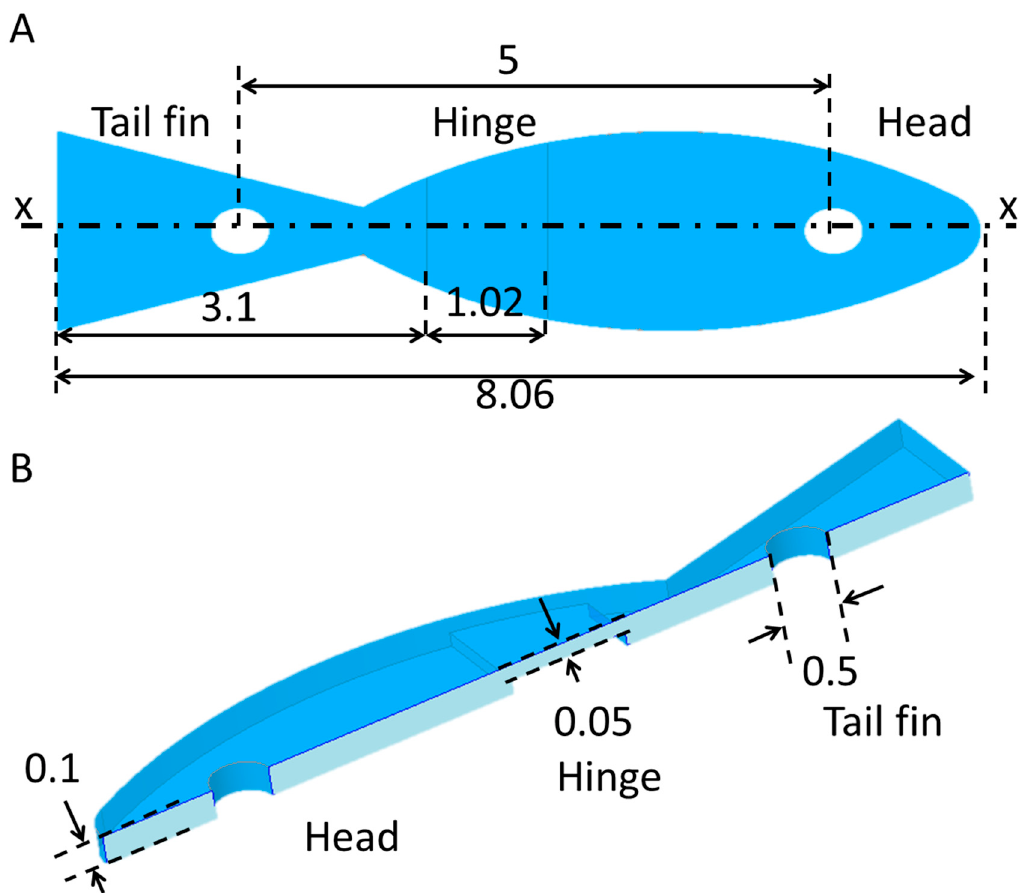
Figure 3. Schematic drawings showing the dimensions (unit: mm) of the prototype swimming robot. ( A ) Top view of the robot body. ( B ) Cross-sectional view on the X-X line in ( A ).